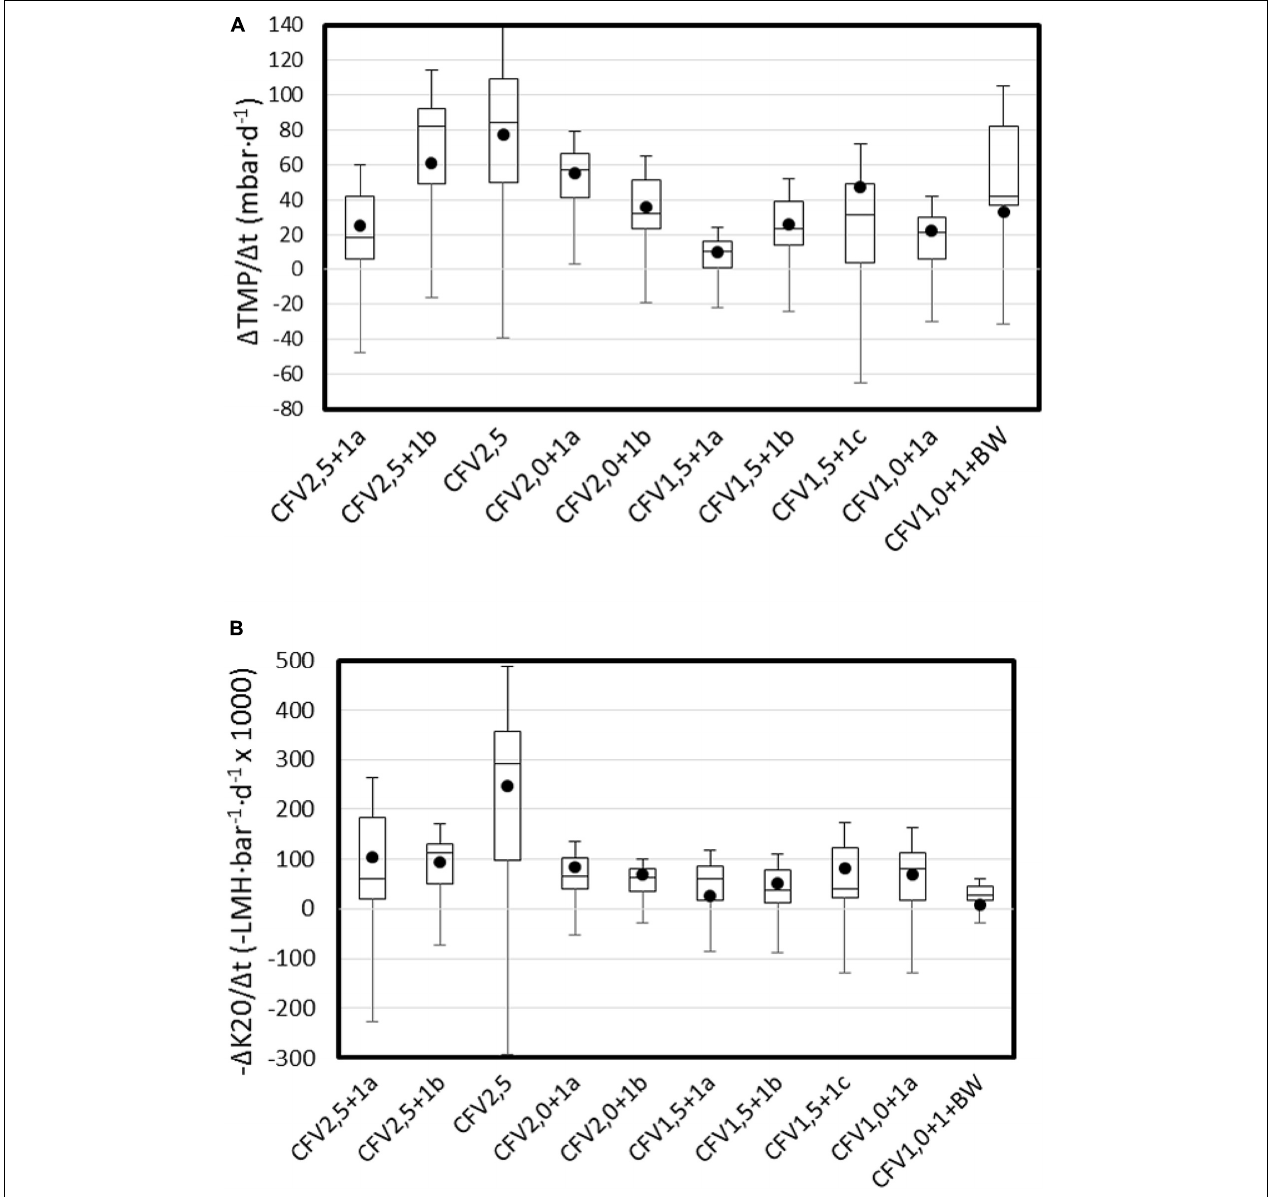
FIGURE 7 | Box plot for (A) daily TMP increase and (B) daily permeability